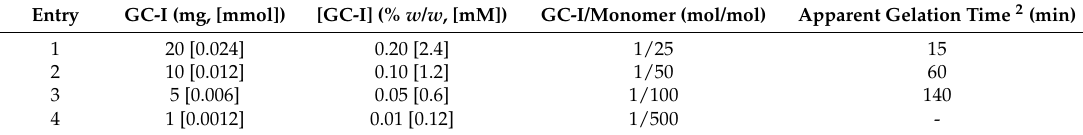
Table 2. Polymerization reactions of aL-9-NBE with different concentrations of GC-I catalyst 1 .